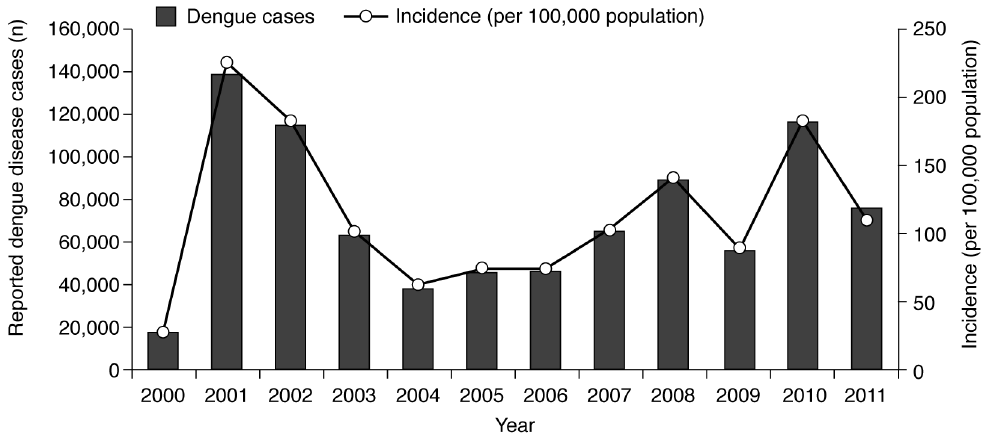
Figure 2. Number of reported dengue disease cases and dengue disease incidence, Thailand, 2000–2011 [23–34]. The number of reported dengue disease cases is plotted against the left-hand vertical axis. Peaks in the number of cases (national epidemics) that were above the 75 th percentile for the period occurred in 2001, 2002 and 2010; another peak (which was at the 70 th percentile) occurred in 2008. The incidence of dengue disease per 100,000 population is plotted against the right-hand vertical axis. The incidence averaged 115 cases annually between 2000 and 2011. No clear trend over time in the number or incidence of reported dengue disease cases could be discerned as the pattern over the review period was complicated by epidemic years.